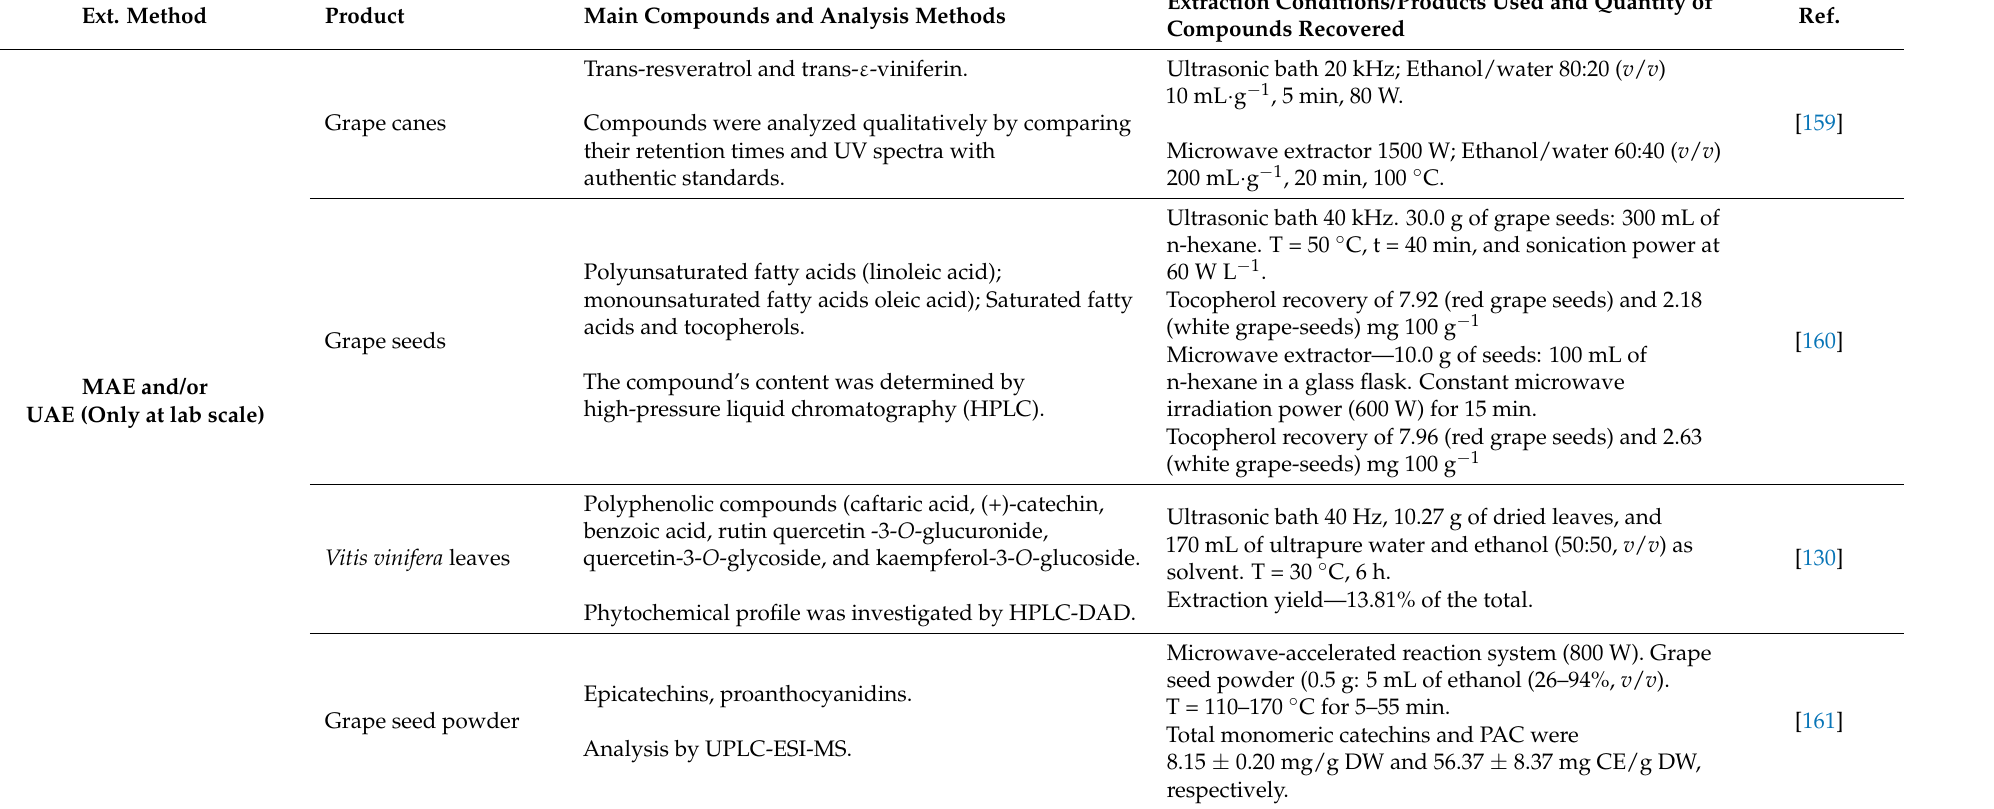
Table 1. Examples of extraction methods, grape/wine residue used, main compounds extracted, and extraction conditions/solvents used. Ext.